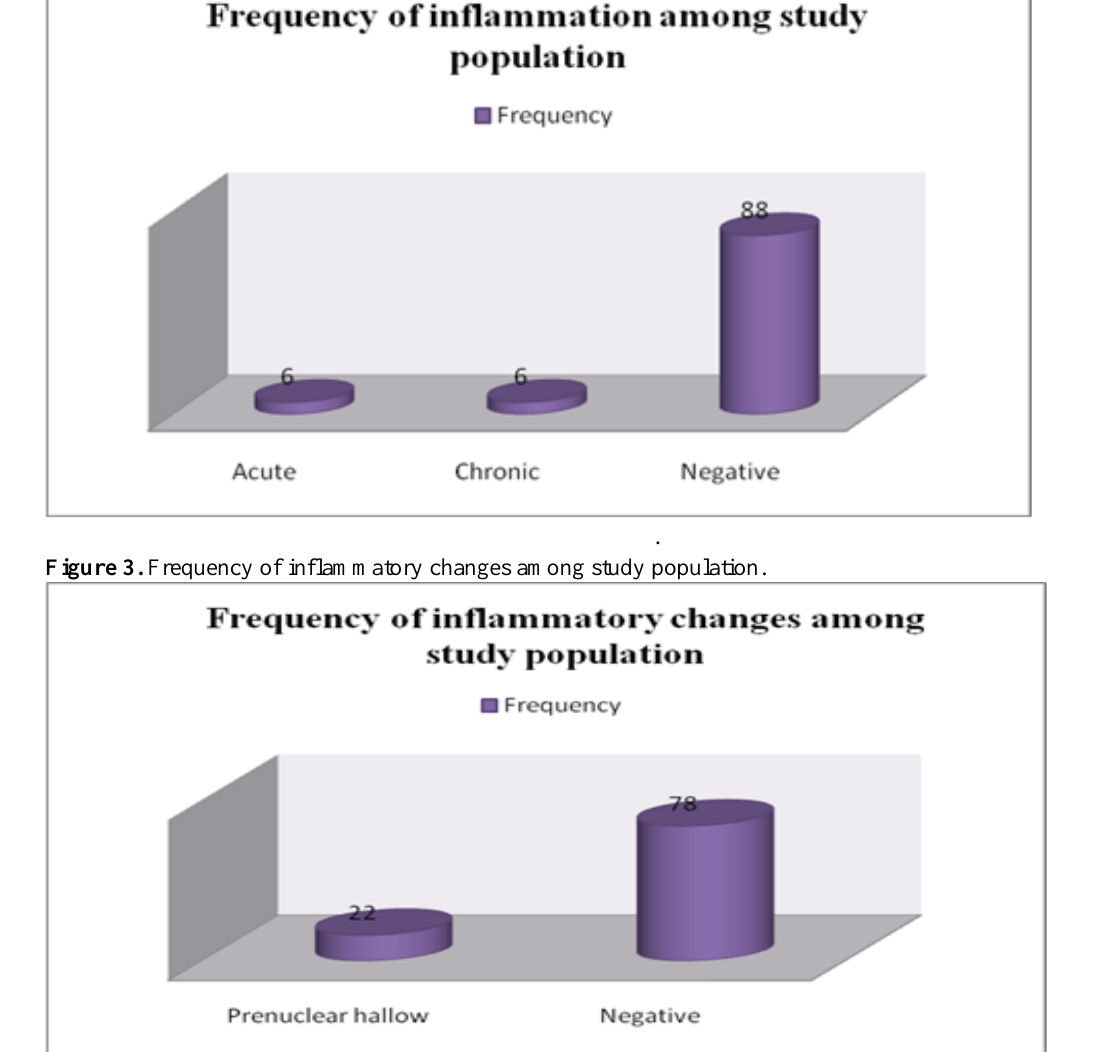
Figure 2. Frequency of inflammation among study population.